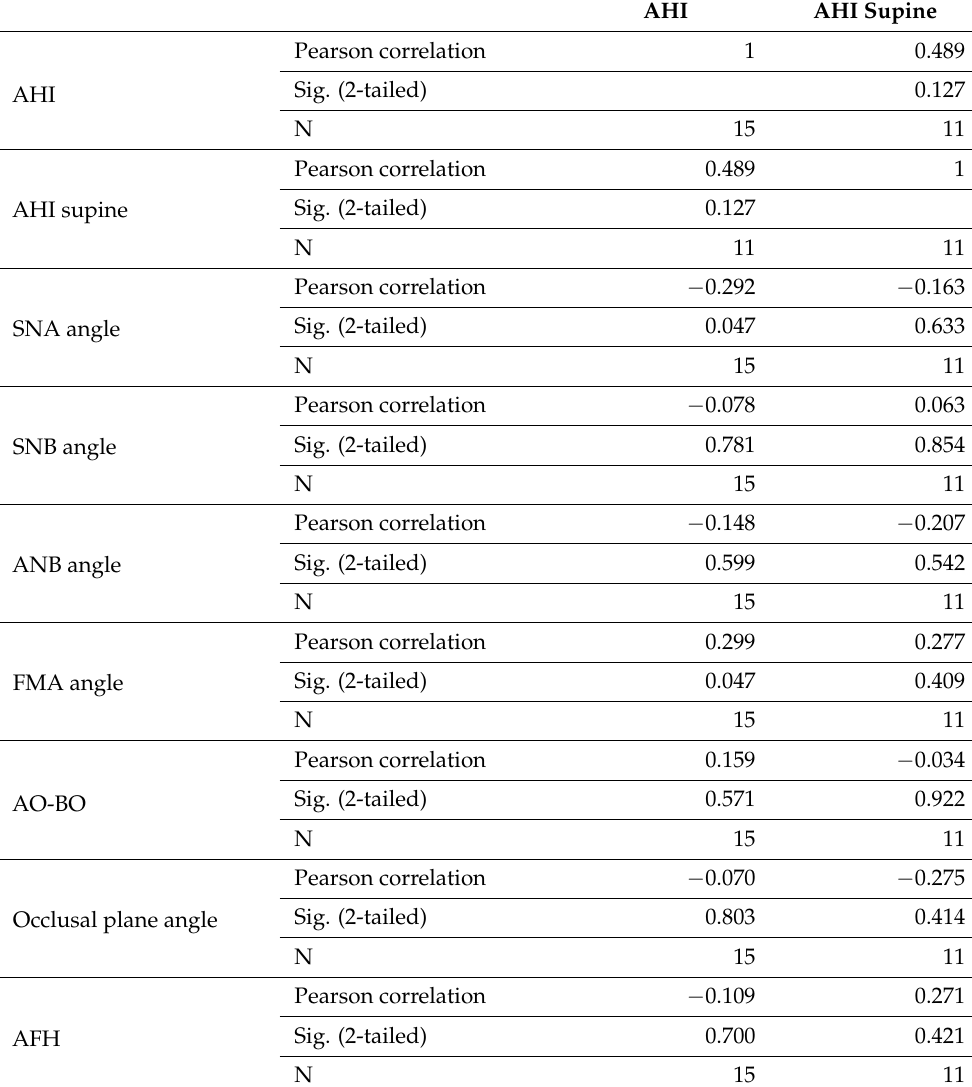
AHI supine) in the normal ‐ weight group (BMI < 25).